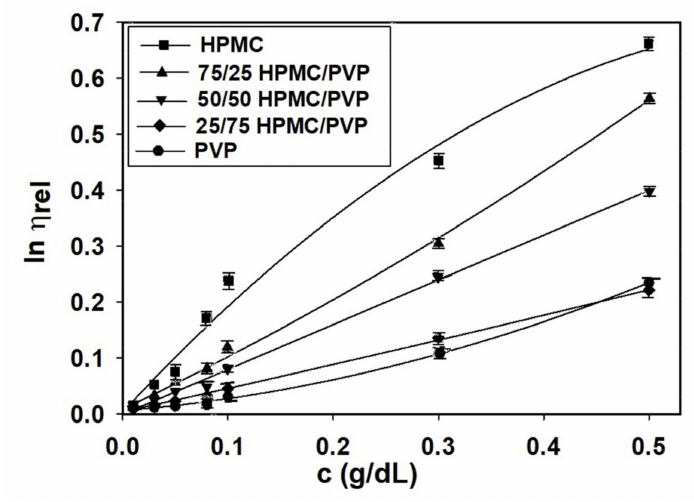
Figure 4. Plots of ln η rel as a function of concentration for HPMC/PVP/water at different mixing ratios and 25 ◦ C.